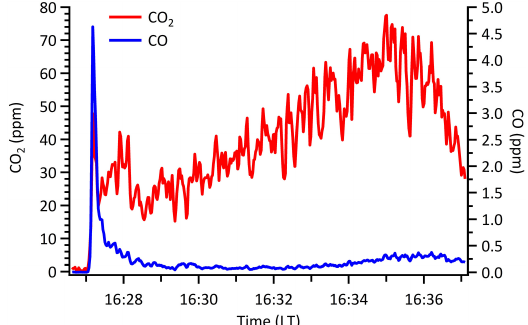
Figure 13. Excess mixing ratio profiles of CO and CO 2 for the FLAME-4 plastic bag burn characterized by a large long-lived ratio of 1 CO 2 /1 CO corresponding to strong flaming